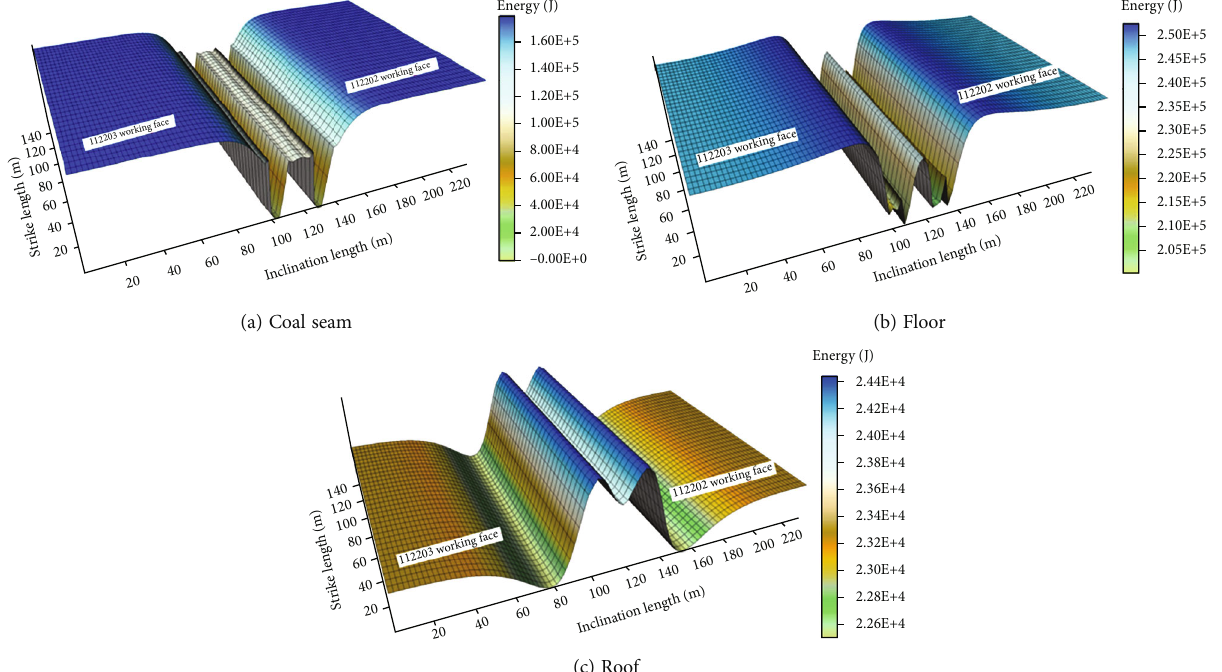
Figure 5: Energy distribution characteristics of the surrounding rock during double roadway excavation.